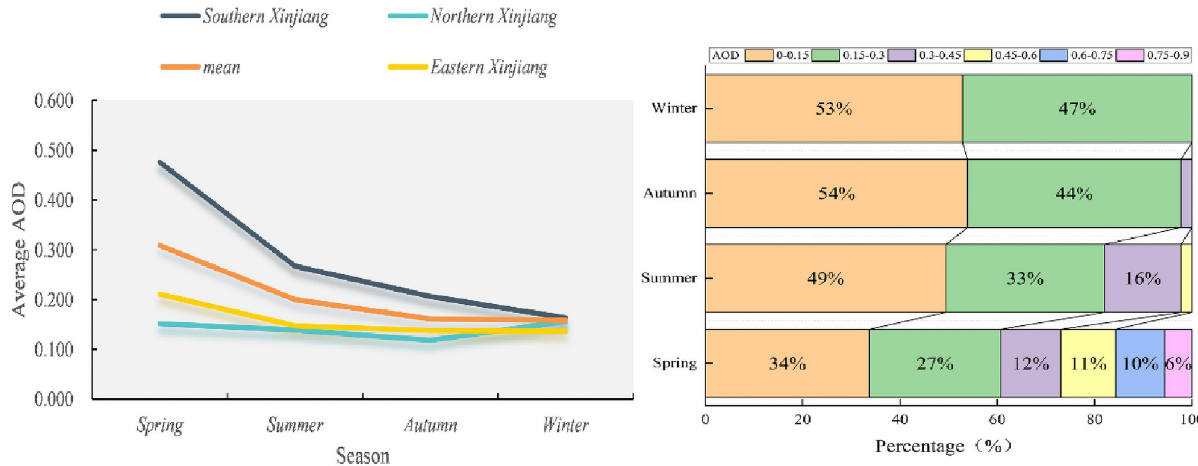
Fig 7. (a) Spatio distribution of the average AOD in each season (spring, summer, autumn, and winter) from 2000 to 2019, and (b) varying degrees of seasonal AOD variations.